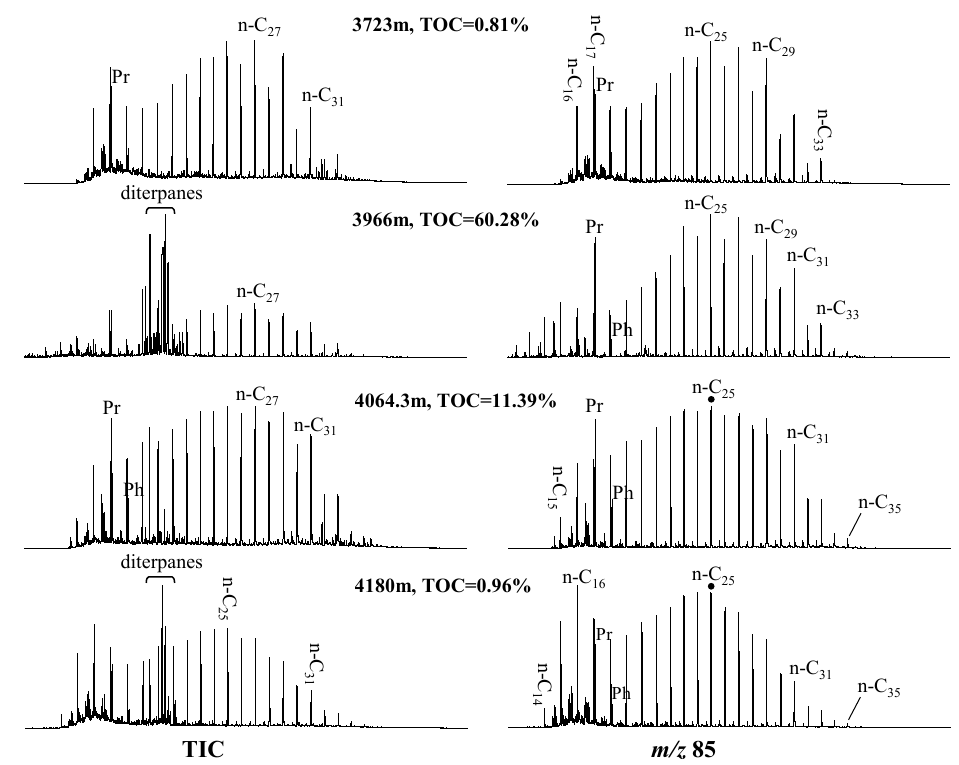
Figure 5. Total ion chromatograms and m/z 85 mass chromatograms of aliphatic fractions of the samples. The prominent peaks eluting between n-C 19 and n-C 21 have been identified as tri- and tetracyclic diterpanes derived from conifer resins.